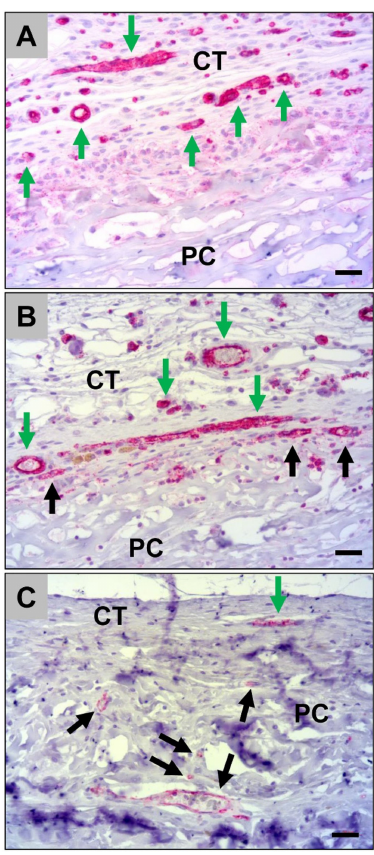
Figure 5. Representative histological images of the vascularization pattern of the porcine pericardium matrices (PC) within the subcutaneous connective tissue (CT) at day 10 ( A ), day 30 ( B ), and day 60 post implantation ( C ). Green arrows = vessels within the surrounding connective tissue, black arrows = vessels within the collagen matrices (CD31-immunostainings, 20 × magnifications, scalebars = 20 µ